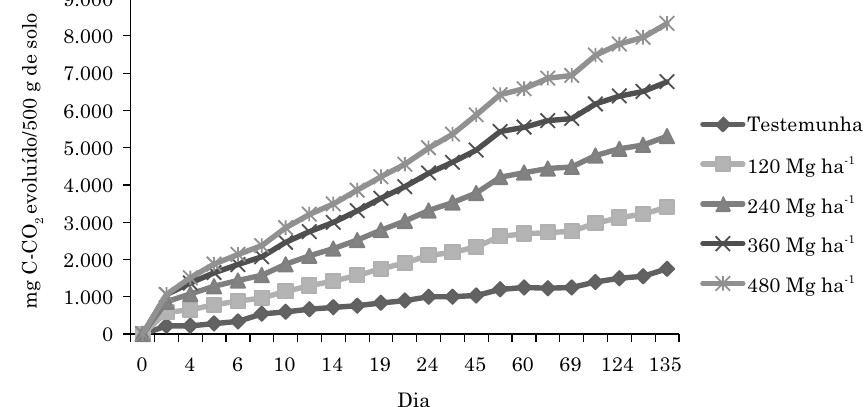
Figura 2. evolução de c-co 2 em razão das doses de lodo de esgoto aplicadas no ensaio ii em Nitolosso Háplico álico textura argilosa, coletado da camada de 0,00-0,20 m, de área localizada em piracicaba, sp.